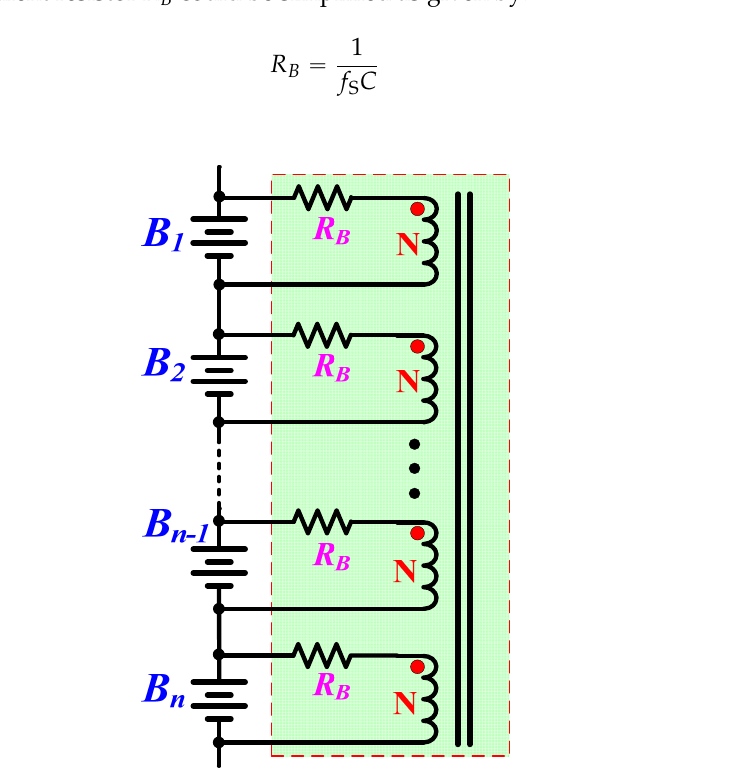
Figure 8. Model of the proposed voltage equalizer.